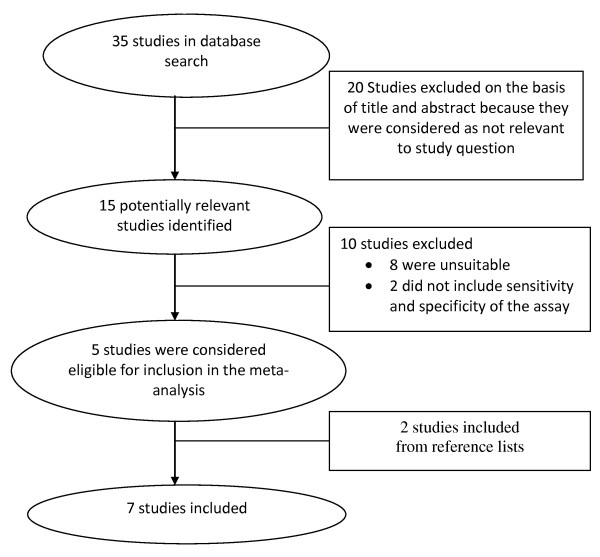
Study selection process.